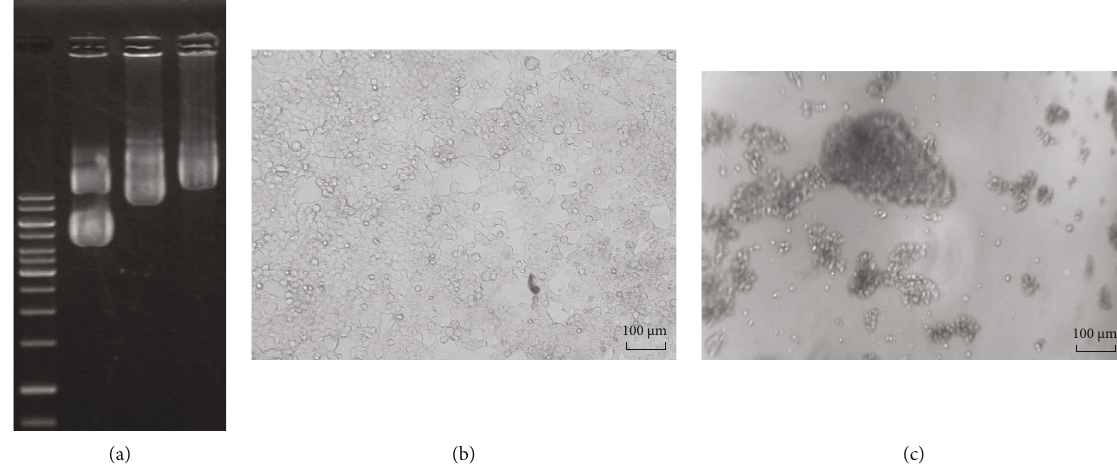
Figure 2: (a) Agarose electrophoresis of pCMV-VSV-G plasmids (runway 1); FUGW carried the CAR gene (CD47 scFv-hinge-CD4TM- CD28-41BB-CD3 ζ ) (runway 2); pCMV-dR8.2 dvpr (runway 3). (b) HEK cells in control sample. (c) Broken HEK cells produce lentivirus.